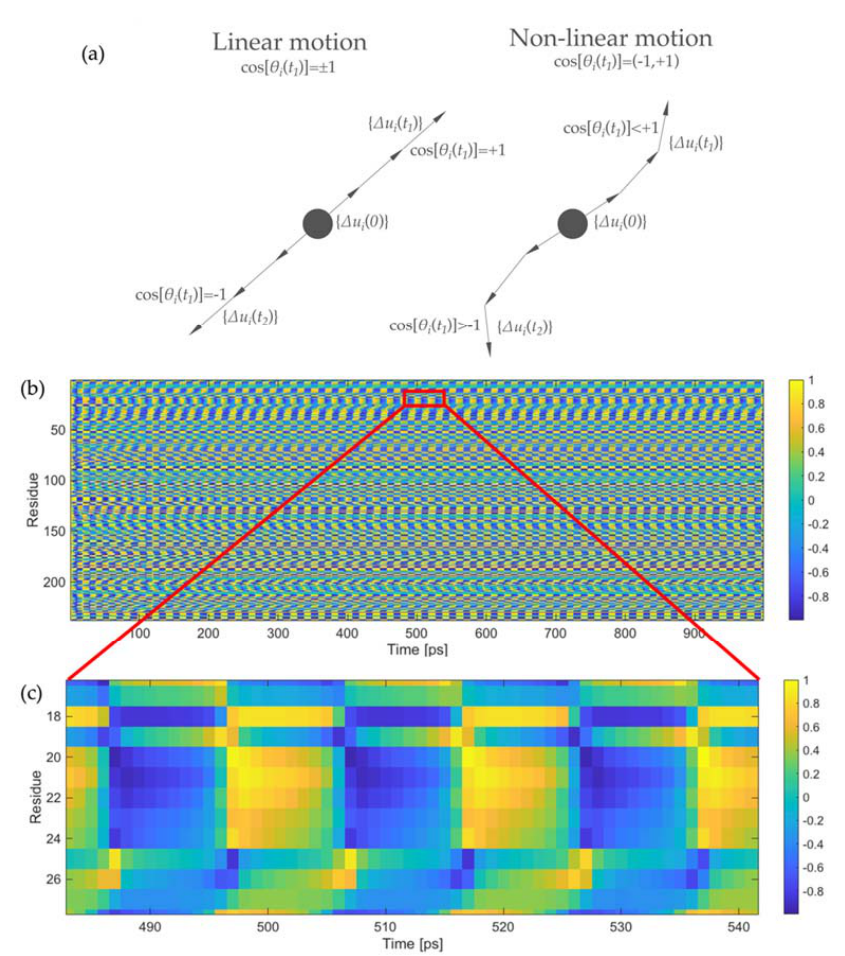
Figure 4. Evaluation of the motion non-linearity: ( a ) Sketch of the vectors for the numerical evaluation of motion non-linearity; ( b ) values of the normalized cosine reported in Equation (20) for the 238 residues of LAO-binding protein for the entire simulation; ( c ) enlarged portion of Figure 4b for the segment 17–27 and in the time frame between 480 and 540 ps. The value of the normalized cosines is reported in color scale, from dark blue (cosine equal to − 1) to bright yellow (cosine equal to +1).